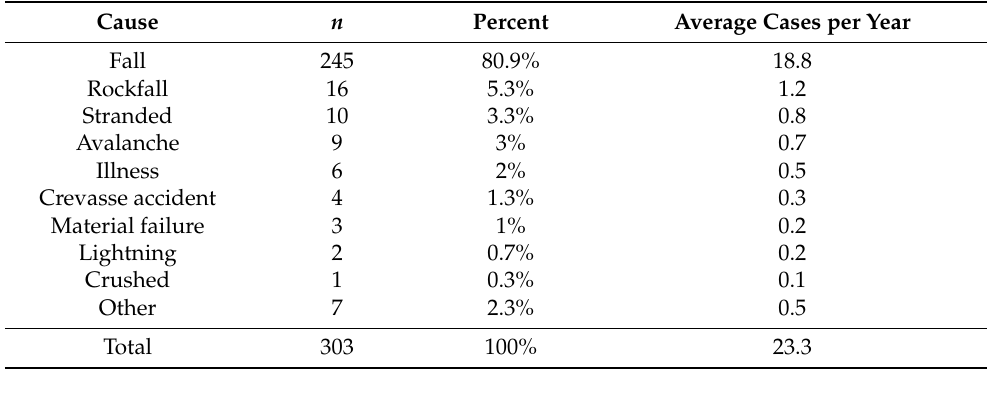
Table 1. Causes of deathly emergencies while high-altitude mountaineering in the Swiss Alps. Being stranded (or blocked) is a mountain emergency where alpinists can no longer continue their tour on their own due, for example, to exhaustion, equipment problems, or weather [16,17].